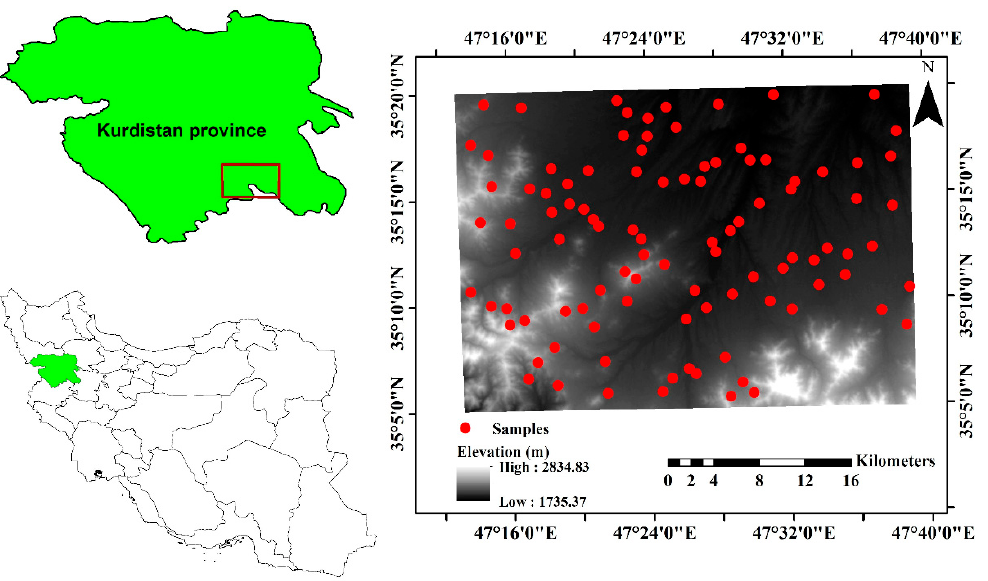
Figure 1. Location of the study area and spatial distribution of the studied points in Kurdistan Province, west of Iran.